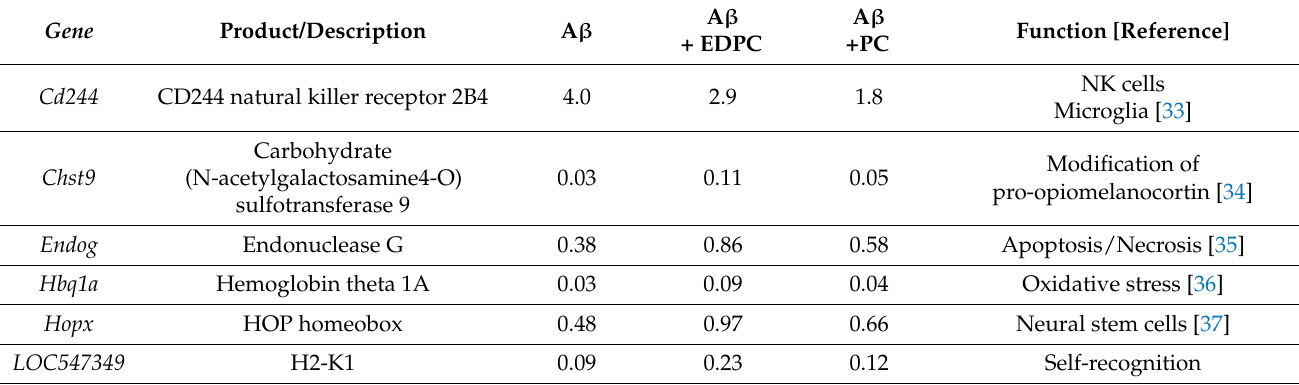
Table 7. Fold change values of the upregulated EDPC-related, not PC-related, genes with respect to the sham group, excluding those shown in Table